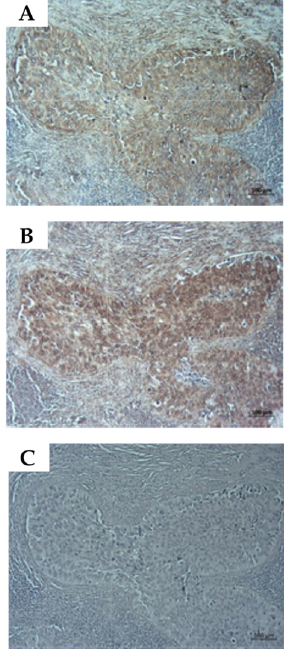
Figure 9. Expression of CD276 and proliferation marker Ki67 in metastases of bladder cancer patients. Paraffin sections from metastases in lymph nodes from bladder cancer patients were stained with ( A ) anti-CD276 and ( B ) with anti-Ki67 antibodies. ( C ) Infiltrating tumor tissue expressed both antigens at elevated levels. Size bars indicate 100 μ M.